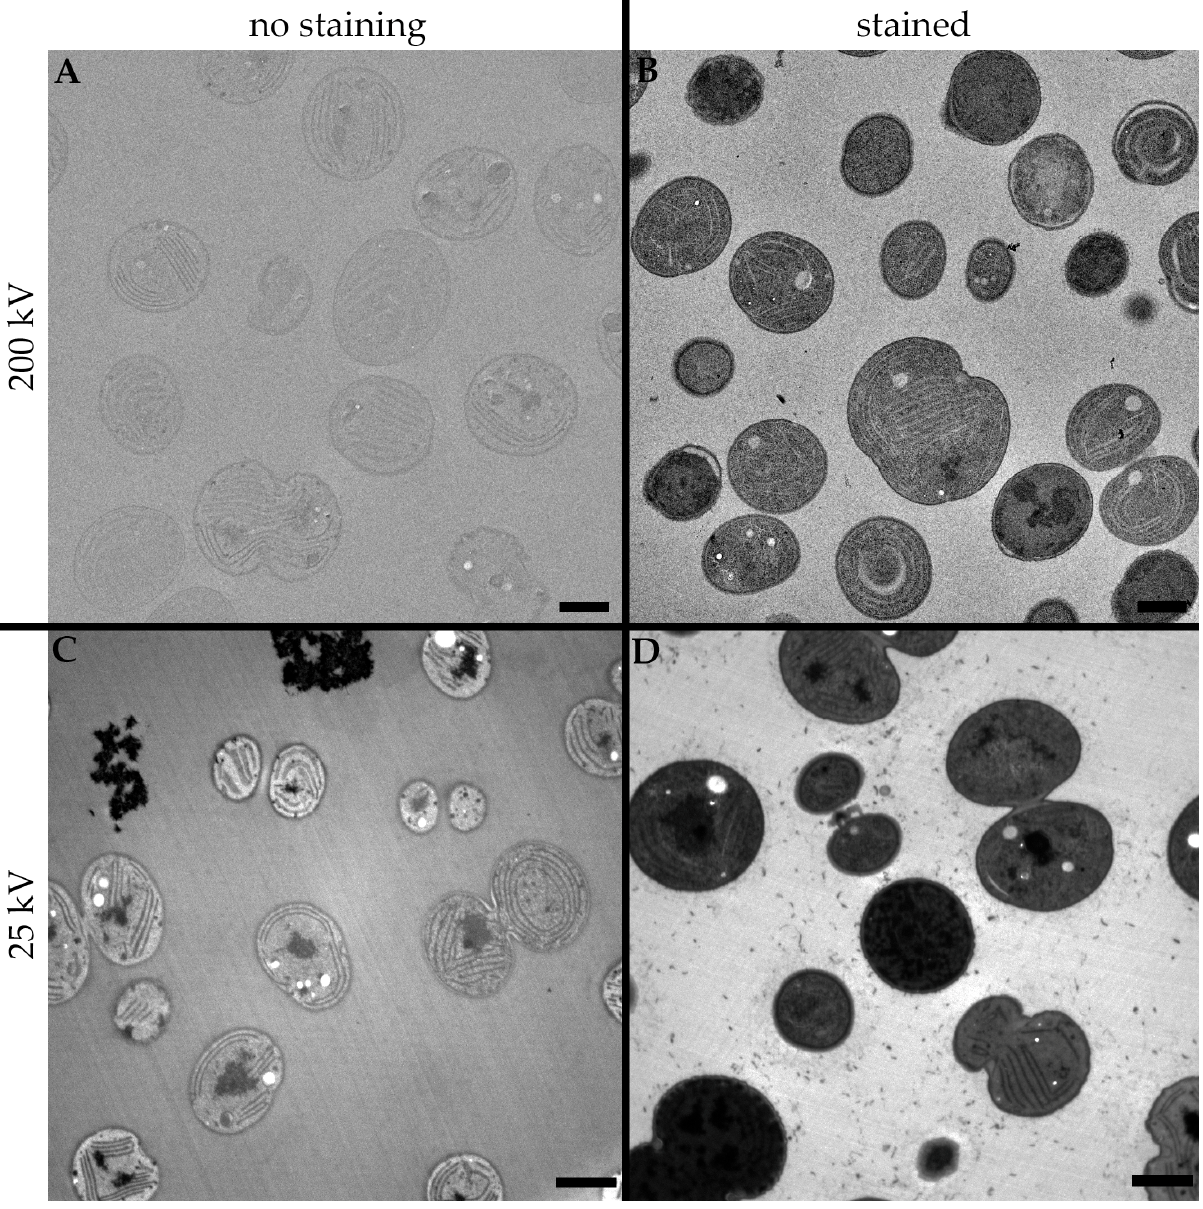
Figure 2. Comparison of the influence of different staining procedures and energies of the electron beam in the final TEM image on cyanobacterial cells. ( A ) A 200 kV accelerating voltage of electron beam without staining, ( B ) 200 kV accelerating voltage of electron beam and staining with uranyl acetate and lead citrate, ( C ) 25 kV accelerating voltage of electron beam without staining, ( D ) 25 kV accelerating voltage of electron beam and staining with uranyl acetate and lead citrate. Scale bar: 1 µm.